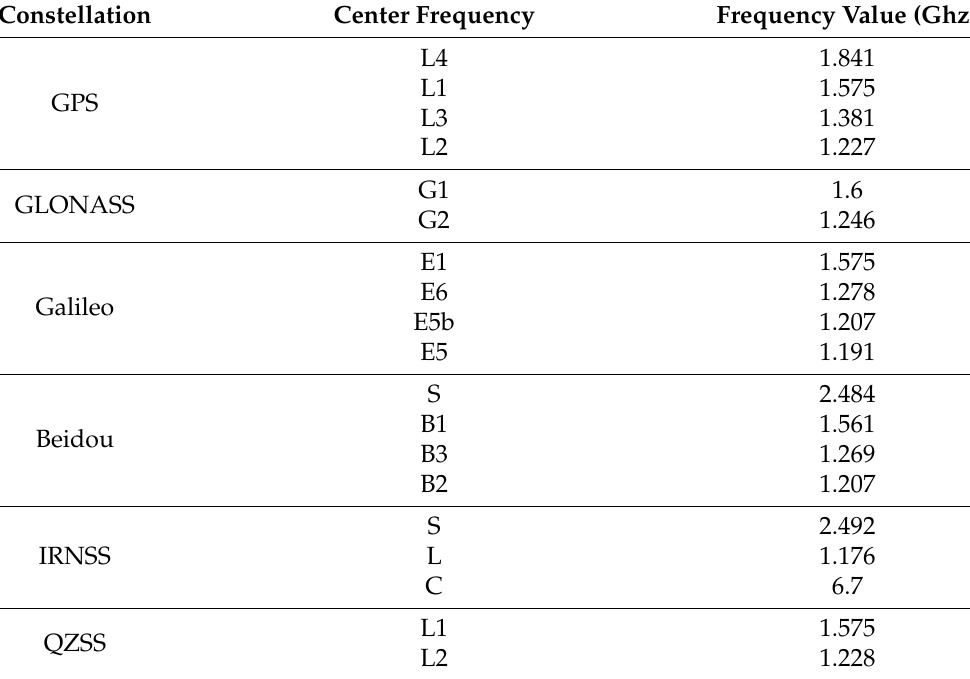
Table 1. Summary of GNSS carrier